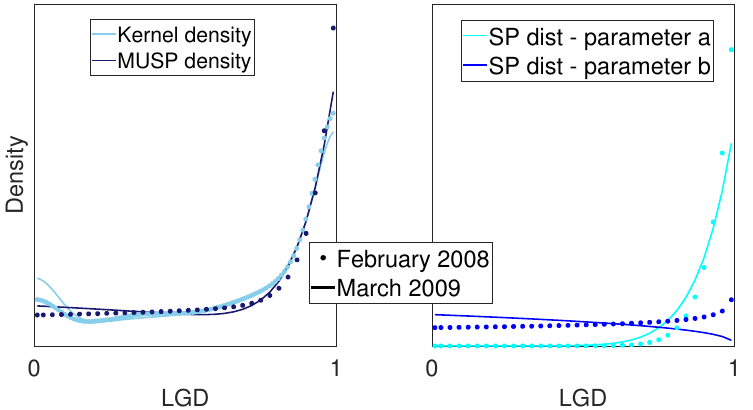
Figure 9. Densities for February 2008 and March 2009 LGD data. On the left, the kernel density is compared to the fitted MSP model, while on the right, the two contributing SP fitted densities of the MSP model are shown, driven by ˆ a and ˆ b , respectively.